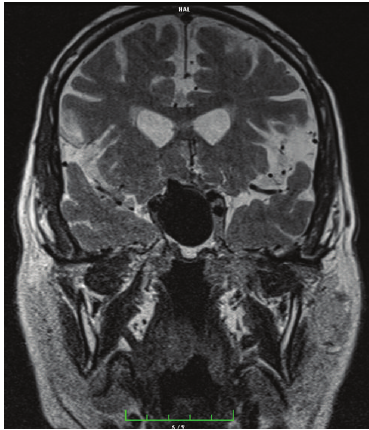
Figure 2: Angiographic image of endovascular treatment with flow- diverter stent and coils.